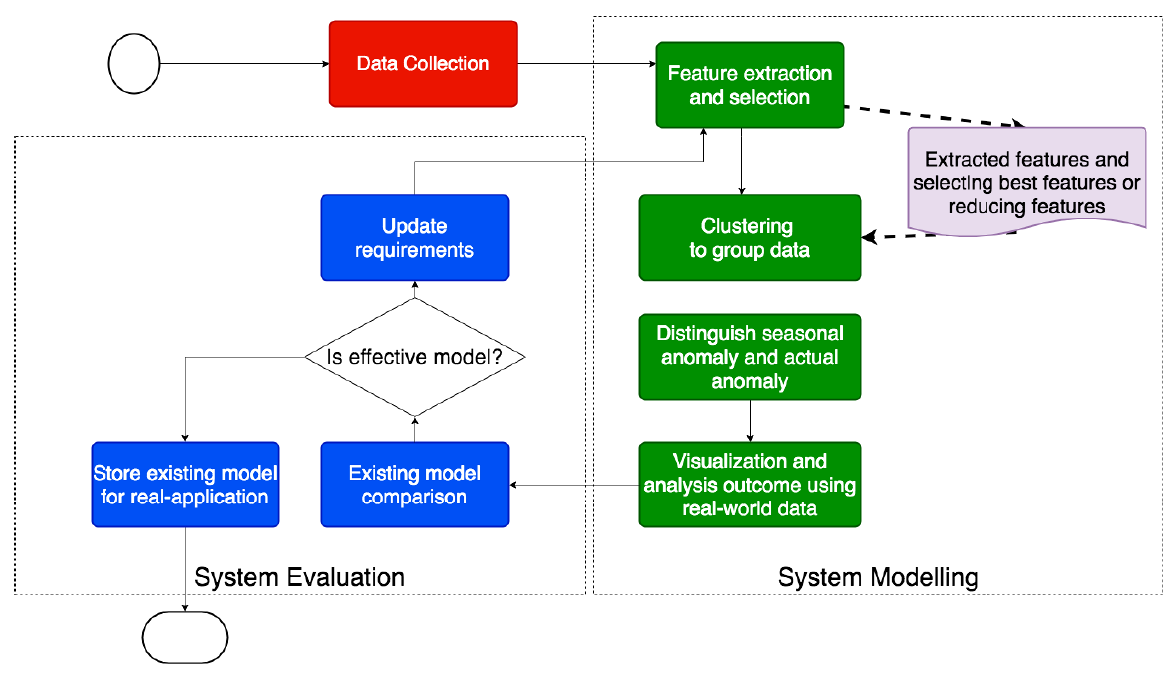
Figure 1. The overall process of the system